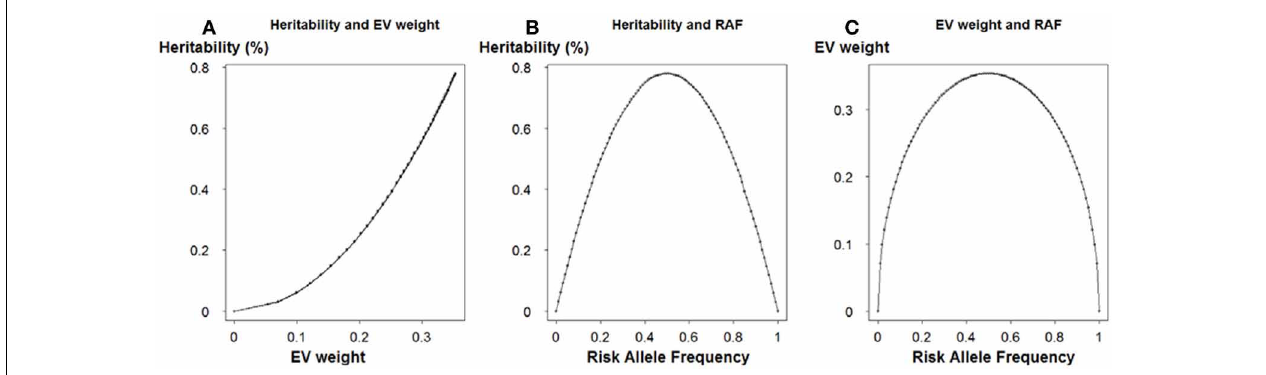
FIGURE 6 | Relationship between risk allele frequency, explained variance weight and heritability. (A) Relationship between heritability and explained variance weight. (B) Relationship between heritability and risk allele frequency. (C) Relationship between explained variance weight and risk allele